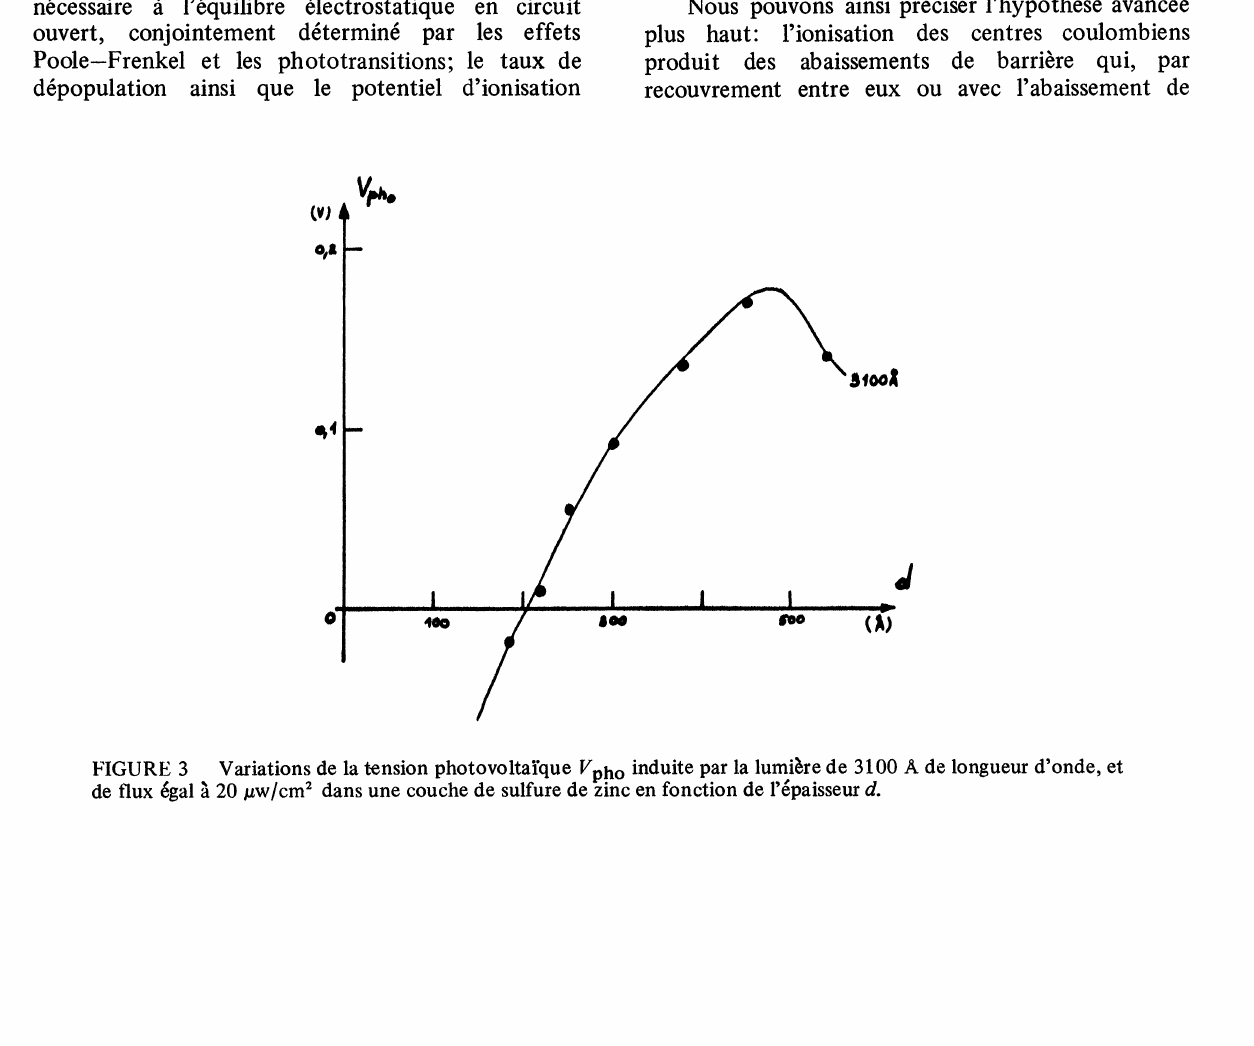
Variations de la tension photovoltai’que Vph o induite par la lumire de 3100 A de longueur d’onde, et ’ 20 tzw/cm dans une couche de sulfure de zinc en fonction de l’paisseur de flux gal